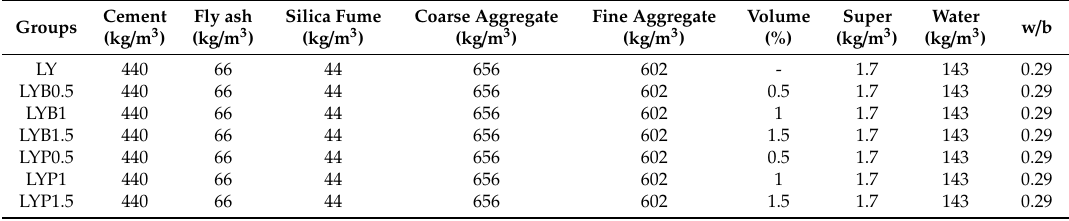
Table 4. Mixture proportions of lightweight aggregate concrete (LWAC) samples.